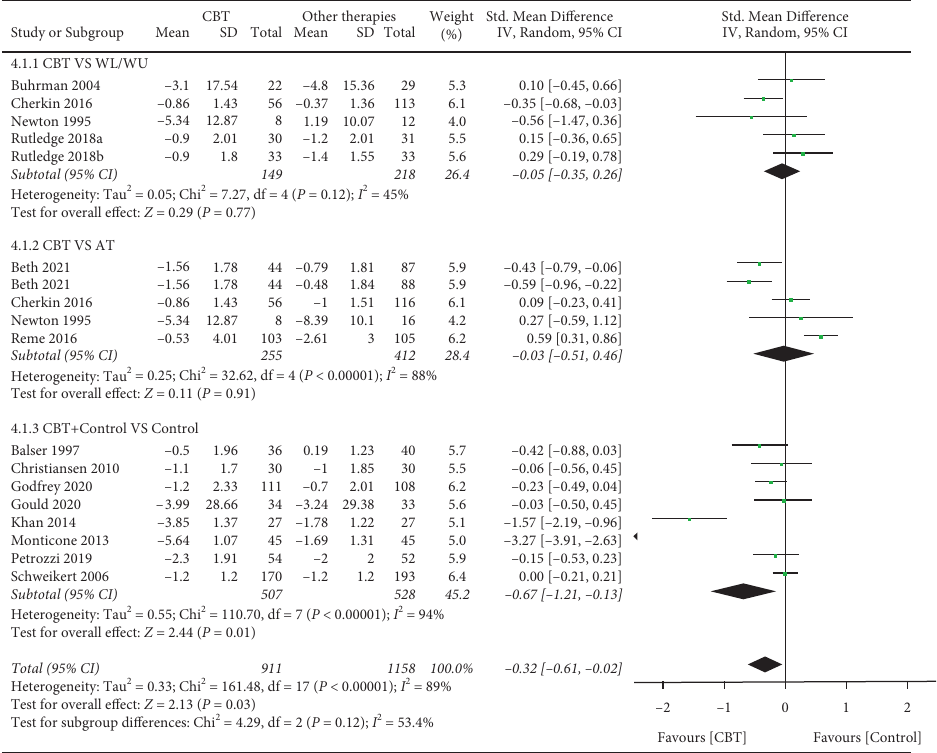
Figure 6: The outcome of the pain of different control subgroups. Combined CBTwith other therapies showed a greater overall effect than other therapies alone ( P < 0 .